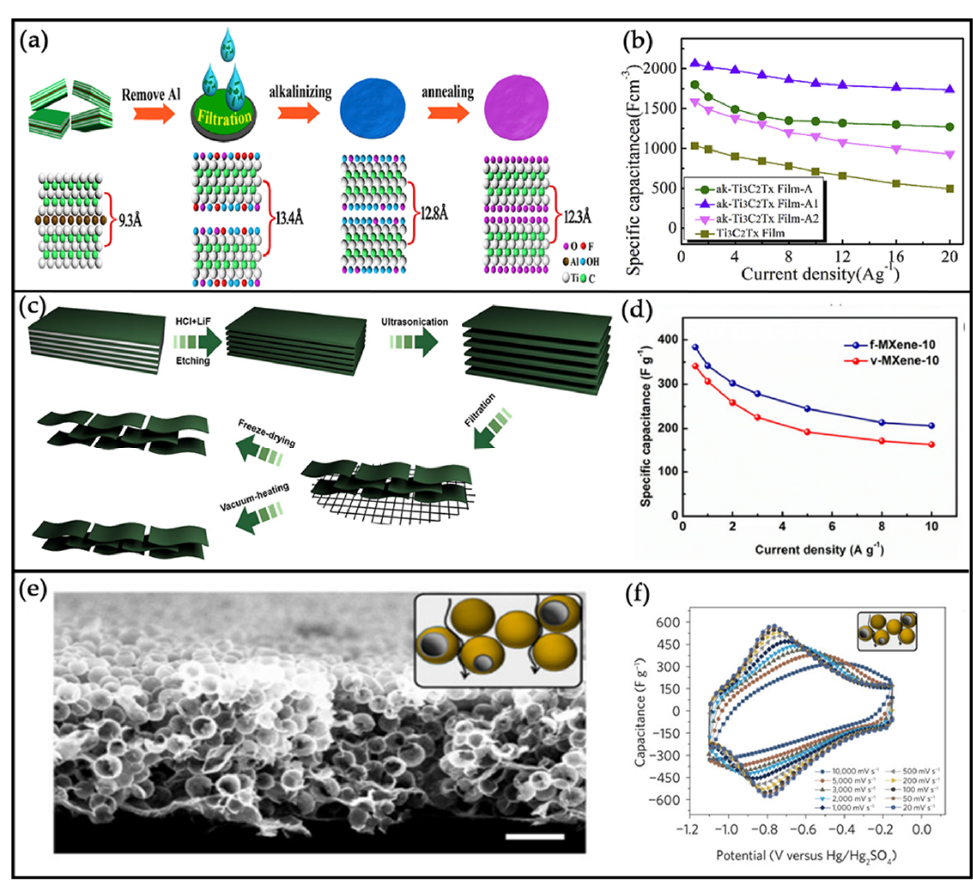
Figure 6. ( a ) Schematic diagram showing the synthesis process of ak−Ti 3 C 2 T x film−A. ( b ) The specific capacitance as a function of current density. Reprinted with permission from Ref. [106]. Copyright 2018 Electrochimica Acta . ( c ) Schematic illustration for the fabrication of f-MXene and v-MXene films. ( d ) Specific capacitance of f−MXene−10 and v−MXene−10 at different current densities. Reprinted